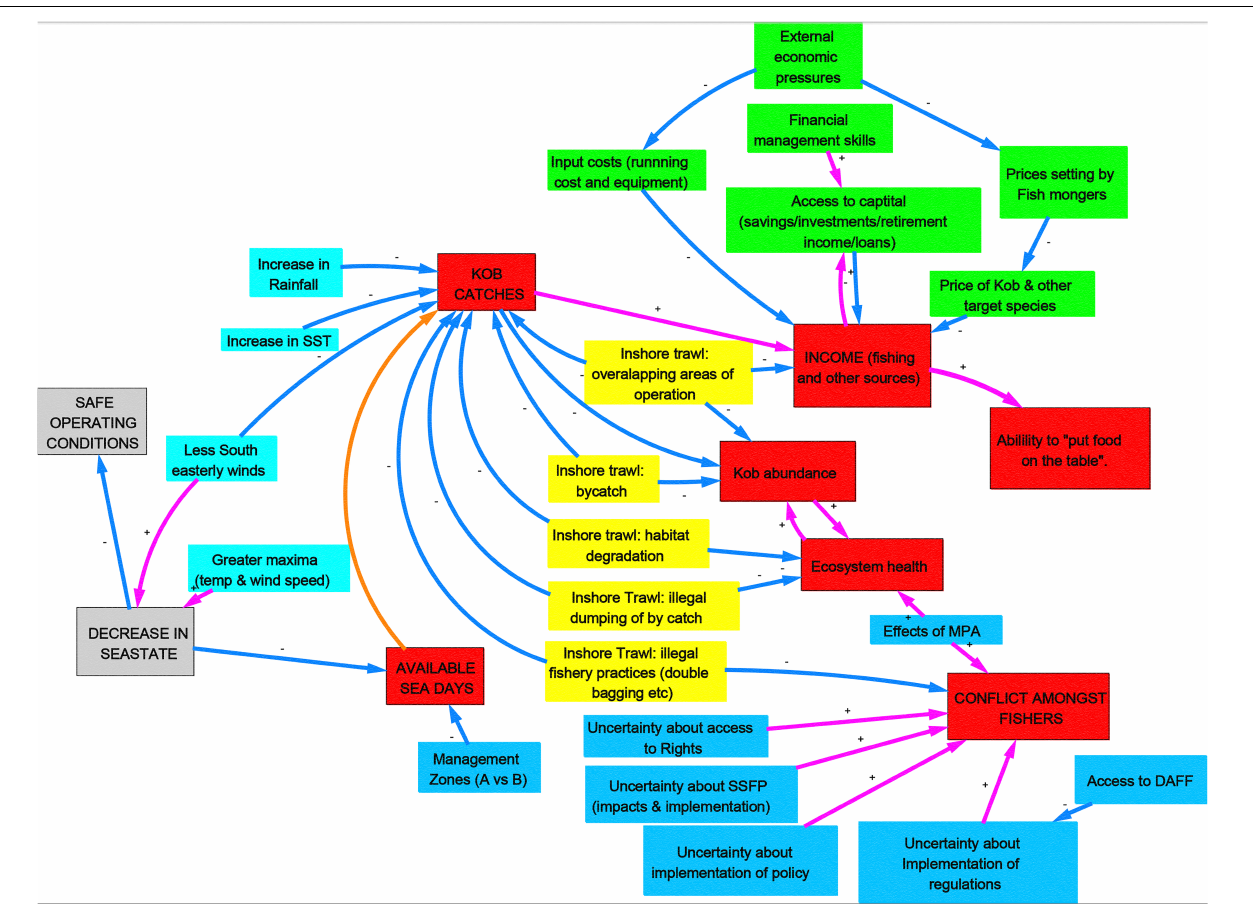
FIGURE 2 | Base map (first iteration) derived from the stressor framework identified by Gammage (2015) and Gammage et al. (2017a). Although feedback loops are present in the map and visible to the trained eye, these feedback loops or indirect stressors are not explicitly highlighted in this first iteration of the map. See Table 1 for colour